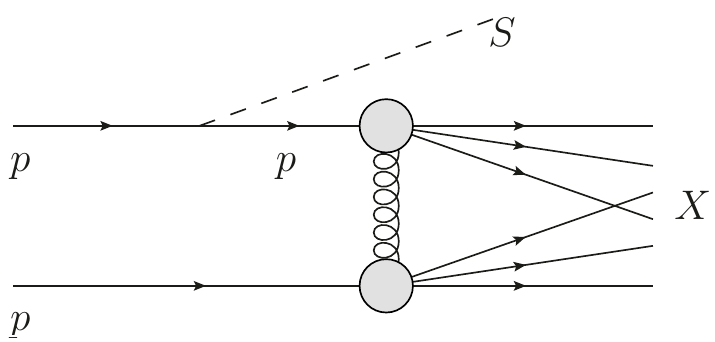
Figure 17 . The probability of the production of a scalar S in bremsstrahlung process versus the scalar mass.